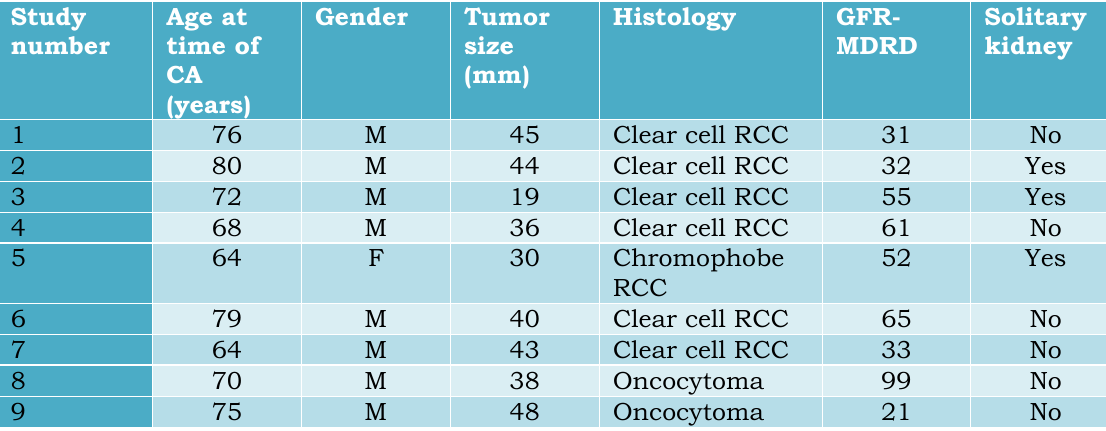
Table 1. Patient characteristics and demographics